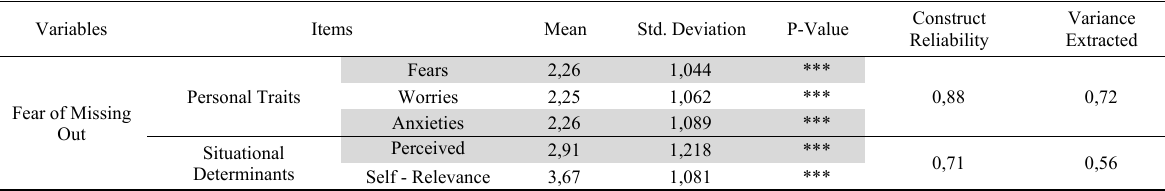
Measurement of FOMO